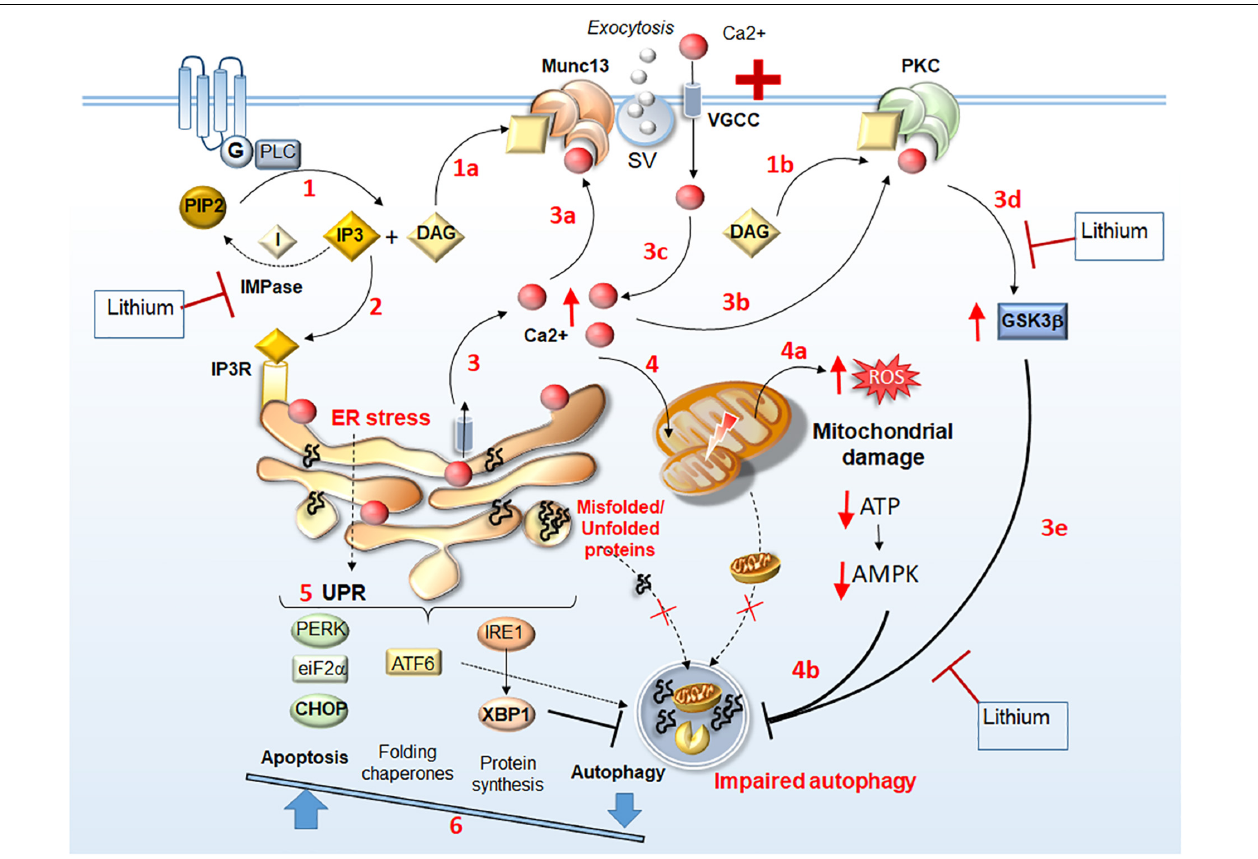
FIGURE 1 | Identifying lithium-sensitive events related to Munc13 and PKC alterations. Following stimulation of G-coupled receptors, PLC is recruited to produce DAG and IP 3 (1). DAG acts a binding substrate for both Munc13 and PKC activation (1a, 1b, respectively), while IP3 binds to IP3 receptors (IP3R) on the ER (2) to mobilize Ca 2 + from internal stores (3). This leads to an increase of intracellular Ca 2 + , which in turn, acts as a binding substrate for both Munc13 and PKC (3a, 3b, respectively). Abnormal Munc13 and PKC activation lead to abnormal neurotransmitter release (synaptic vesicle, SV exocytosis), further Ca 2 + influx (3c), PKC-dependent GSK3 β activation (3d), and subsequent autophagy impairment (3e). Thus, intracellular Ca 2 + levels increase dramatically leading to ER stress, accumulation of unfolded/misfolded proteins within the ER, and mitochondrial damage (4) along with ROS production, ATP depletion and AMPK downregulation (4a), which contribute to impairing autophagy (4b). The UPR attempts to restore homeostasis by increasing protein folding and degradation while inhibiting protein synthesis through PERK/eIF2a/CHOP, ATF6, and IRE1/XBP1 branches (5). Nonetheless, in conditions of a persistent ER stress, autophagy is also inhibited by XBP1, which shifts the UPR to apoptosis (6). Thus, misfolded/unfolded proteins and damaged mitochondria accumulate leading to a vicious cycle of chronic stress. Lithium may reverse these Munc13- and PKC-related molecular events either via GSK3 β inhibition (steps 3d, 3e) or by reducing IP3 turnover through IMPase inhibition (steps 1,